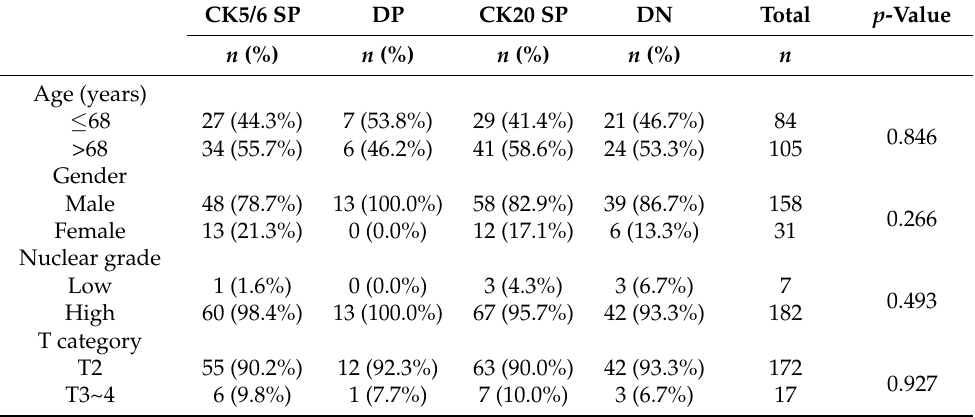
Table 4. Clinicopathological characteristics of patients and association with IHC-defined